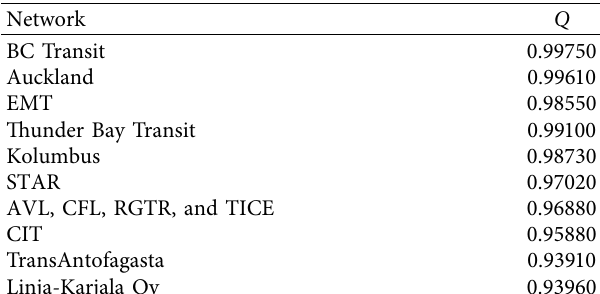
Figure 3: Degree distribution in linear ( x -axis) and linear scale ( y -axis) for the following networks: EMT (a), BC Transit (b), Kolumbus (c), Auckland (d), TransAntofagasta (e), Linja-Karjala Oy (f), AVL, CFL, RGTR, TICE (g), STAR (h), CIT (i), and Thunder Bay Transit (j). Table 3: Q Modularity computed using the overlapping cluster generator (OCG) method in